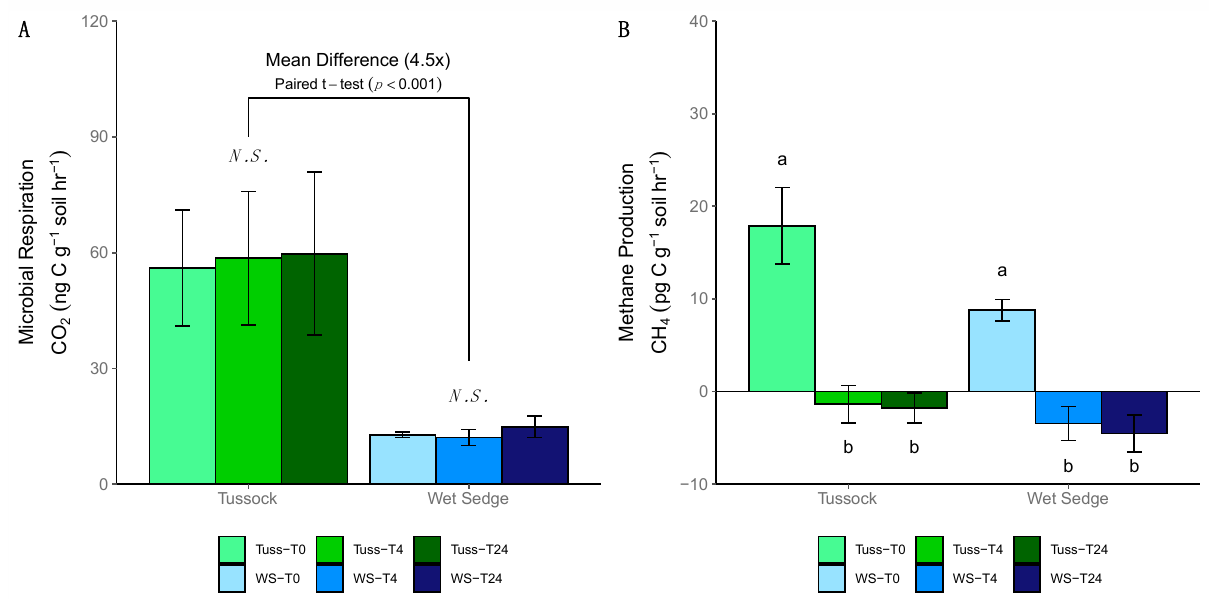
Figure 6. Barplot of production rates for ( A ) microbial respiration and ( B ) methane (CH 4 ) production for tussock tundra and wet sedge tundra communities (error bars represent standard deviation of the mean). Letters indicate significant differences in mean pairwise similarity between sampling time points (ANOVA, p < 0.05), with non-significant differences between sampling time points indicated as N.S. Negative values for CH 4 production indicate CH 4 consumption.